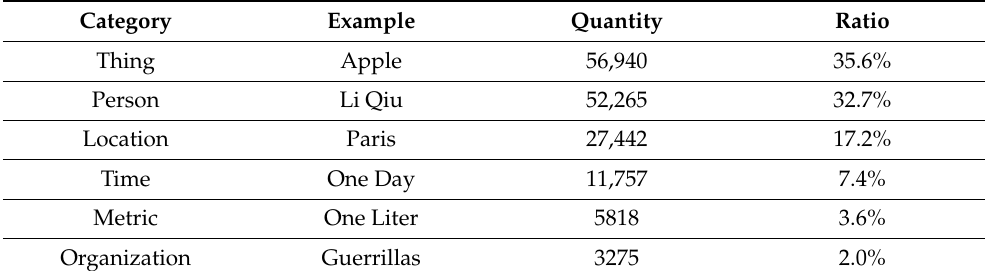
Table 2. The set of entity labels.